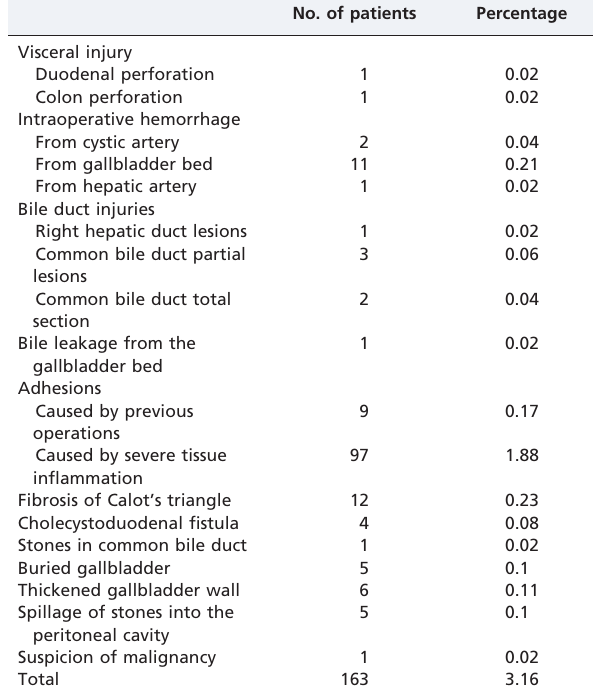
Table 2 - Underlying causes of conversion to